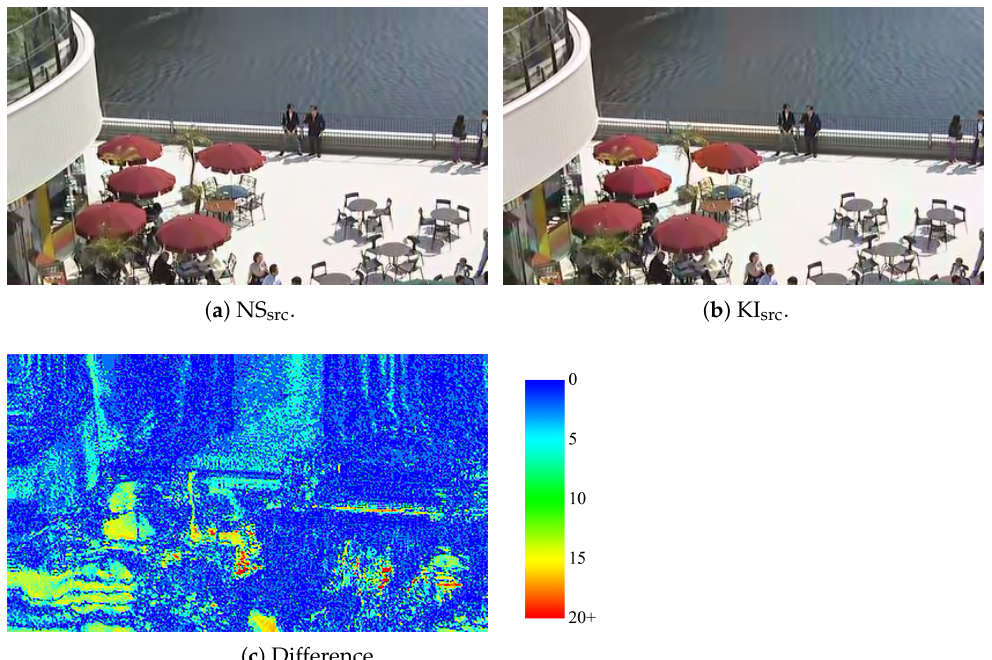
Figure 8. Frames of the BQSquare -sequence with QP NS = QP CS = 27, which corresponds to the worst-case VMAF score decrease for those QP values. ( a ) The frame of NS src without drift-error artifacts. ( b ) The frame of KI src with drift-error artifacts. ( c ) The differences between subfigures ( a , b ). It is recommended to view these images in color,